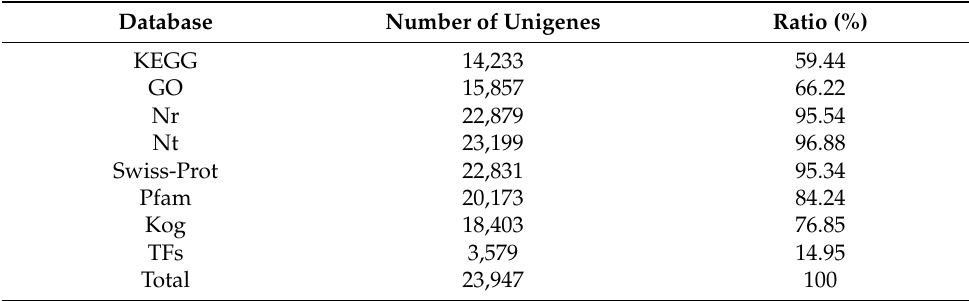
Table 1. Results of Unigene Annotation with the Eight